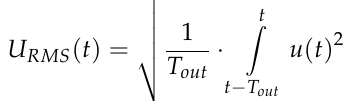
Figure 8. Simulation results at 60 electrical degrees angle of connection (T = 80 °C).